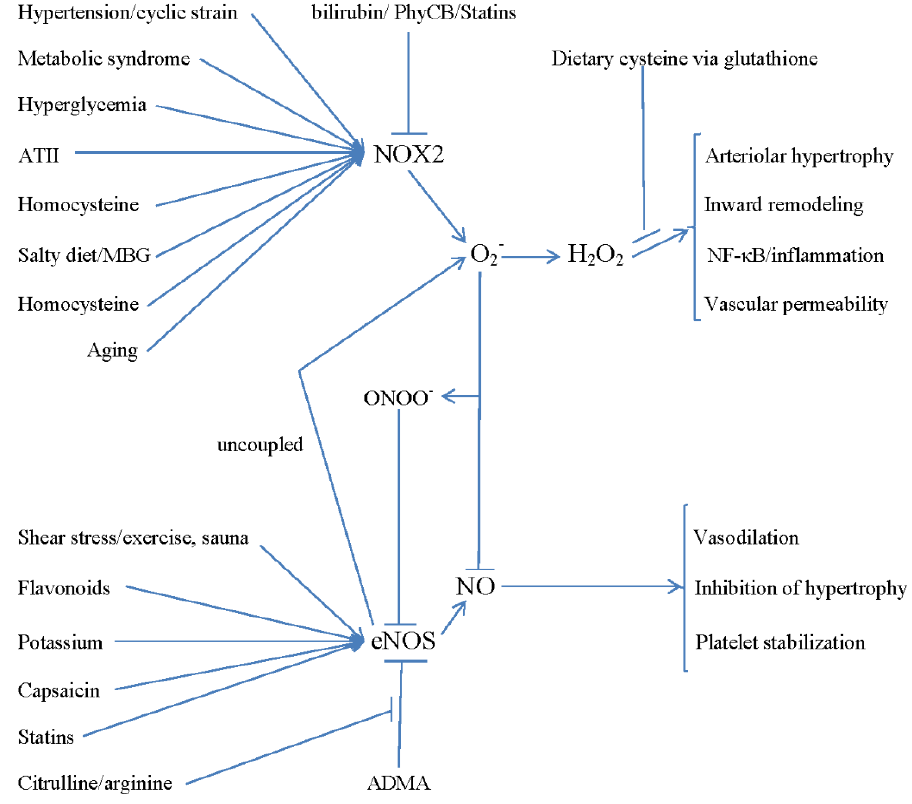
Figure 1. Mechanisms Regulating the Balance of Nox2 and eNOS Activity in Cerebrovascular Endothelium, and their Functional